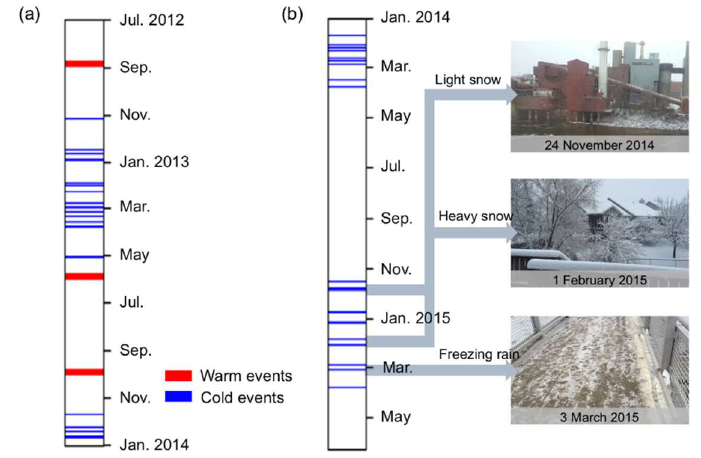
Figure 2. Data periods and precipitation events used for ( a ) model training and Monte Carlo Simulation (MCS) analysis and ( b ) independent model evaluation. Table 3. The sample size of precipitation classes for the training (2012–2013) and validation (2014– 2015) periods.